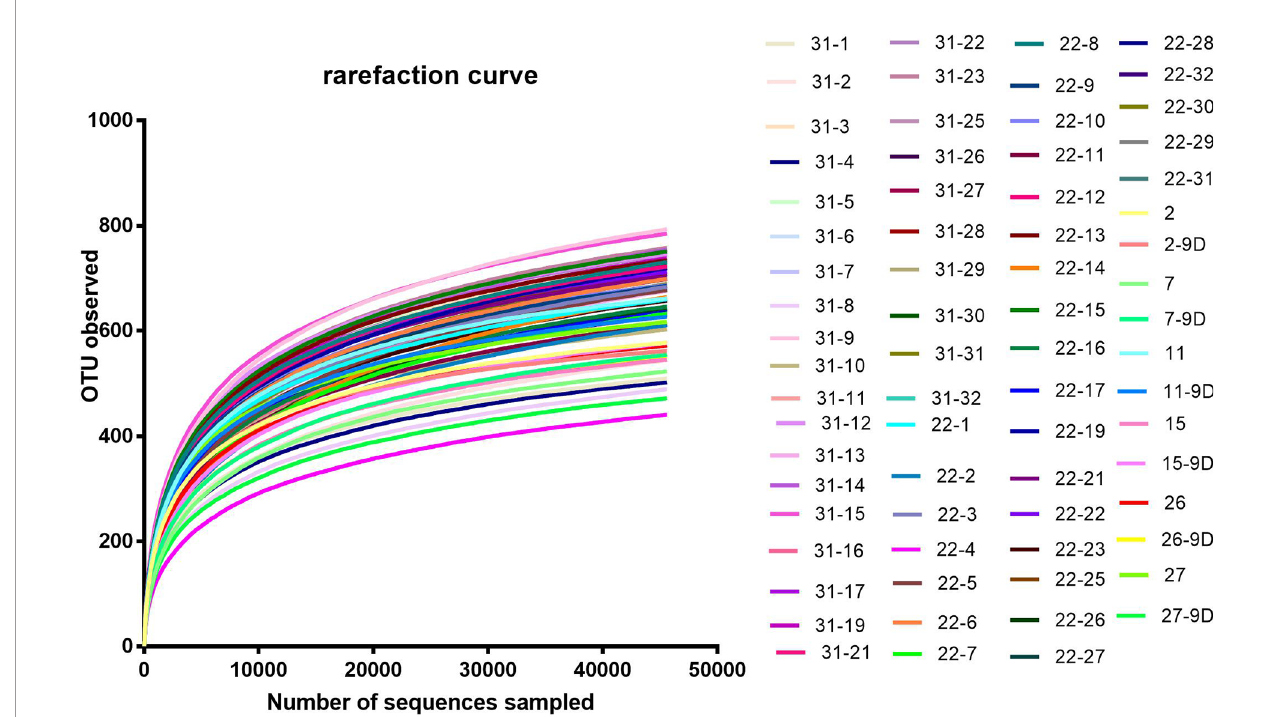
FIGURE 2 | Rarefaction curve. Rarefaction curves were based on the 16S rRNA gene sequencing of the all samples from baseline group and the post-treatment for morphine and saline group. The rarefaction curve suggested that the sequencing depth was satisfactory and represented the majority of bacterial species, because the curves became relatively fl at as the number of sequences analyzed